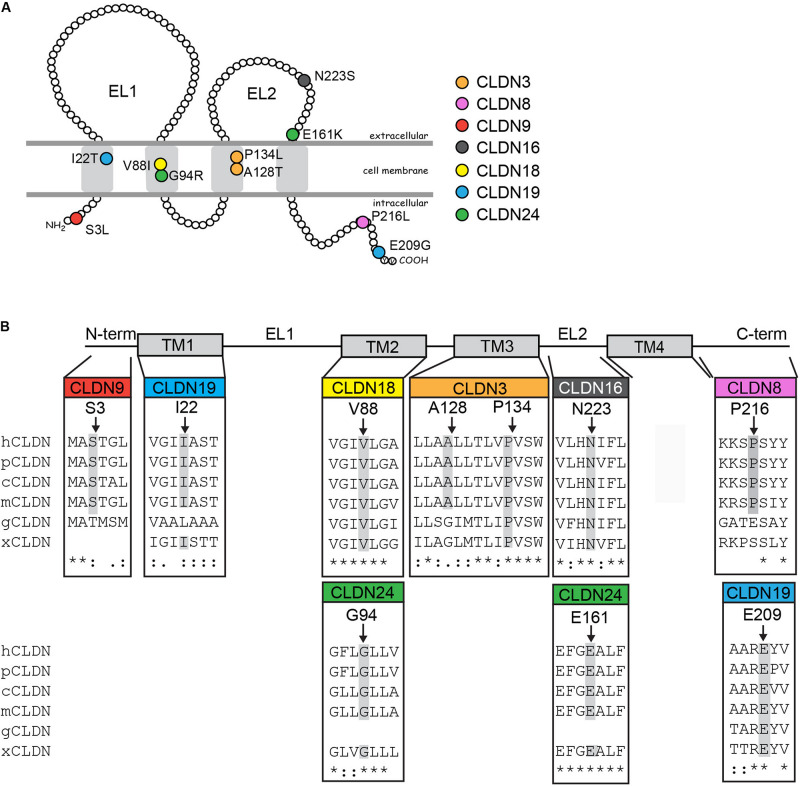
Rare and novel CLDN mutations in NTD patients and conservation of substituted residues. (A) Schematic of a claudin protein in the context of the apical lateral membrane. The approximate positions of mutations identified are shown. (B) Partial ClustalW protein sequence alignment of human CLDNs at the positions of the identified substitutions in the CLDN with a subset of vertebrate orthologs. Abbreviations are as follows: h, Homo sapiens; p, Pan troglodytes; c, Canis lupus familiaris; m, Mus musculus; g, Gallus gallus; x, Xenopus. The amino acid position of CLDN variants found in NTD patients are indicated by arrows and residues conserved at this position in other species are highlighted in gray. Homo sapiens accession numbers: CLDN3, NP_001297.1; CLDN8, NG_050758.1; CLDN9, NP_066192.1; CLDN16, NP_006571.1; CLDN18, AAF26448.1; CLDN19, Q8N6F1.2; CLDN24, NP_001172078.1. Pan troglodytes: CLDN3, XP_016813082.1; CLDN8, XP_531532.1; CLDN9, XP_016784715.1: CLDN16, XP_001161102.2; CLDN18, XP_526318.3; CLDN19, XP_003949437.2; CLDN24, XP_003310625.1. Canis lupus familiaris: CLDN3, NP_001003088.1; CLDN8, XP_005638865.1; CLDN9, XP_005621712.1: CLDN16, XP_850268.2; CLDN18, XP_534274.2; CLDN19, XP_848612.2; CLDN24, XM_540033.4. Mus musculus: Cldn3, NP_034032.1; Cldn8, NM_018778.3; Cldn9, NP_064689.2; Cldn16, NP_444471.1; Cldn18, AAF26447.1; Cldn19, NP_694745.1; Cldn24; NP_001104788.1. Gallus gallus: CLDN3, NP_989533.1; CLDN8, XP_004938436.1; CLDN9, XP_004946475.1; CLDN16, XP_426702.1; CLDN18, XP_003641778.1; CLDN19, XP_003642589.2. Xenopus: Cldn3, NP_001087400.1; Cldn8, XM_004912158.4; Cldn16, XP_002934087.1; Cldn18, NP_001083443.1; Cldn19, XP_002937080.1; Cldn24, XP_018098209.1.